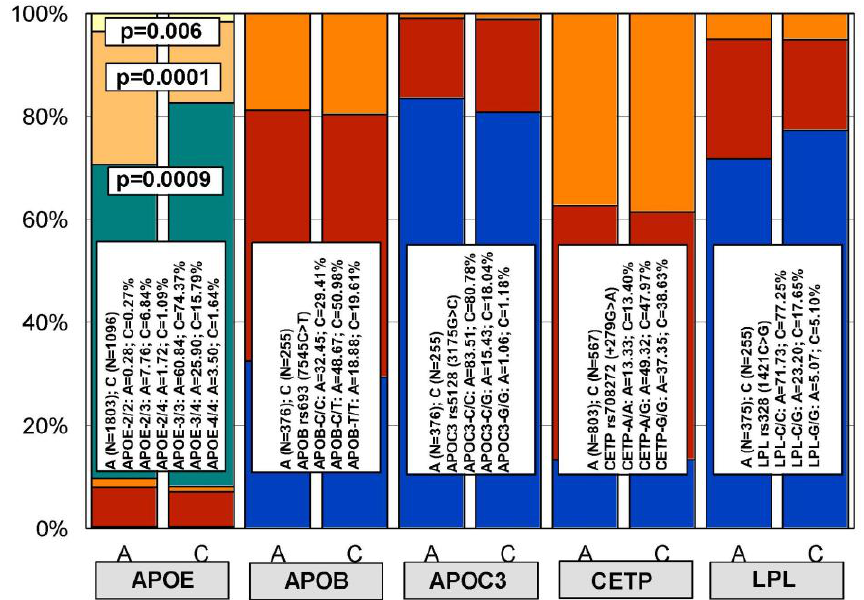
Figure 3. Distribution and frequency of polymorphic variants of the APOE , APOB , APOC3 , CETP, and LPL genes in the general population and in patients with Alzheimer’s disease. A: Alzheimer’s disease; C: Control Population. Color codes: Blue: APOE-2/2 , APOB-C/C , APOC3-C/C , CETP-A/A , LPL-C/C ; Red: APOE-2/3 , APOB-C/T , APOC3-C/G , CETP-A/G , LPL-C/G ; Orange: APOE-2/4 , APOB-T/T , APOC3-G/G , CETP-G/G , LPL-G/G ; Green: APOE-3/3 ; Golden: APOE-3/4 ; Yellow: APOE-4/4 .